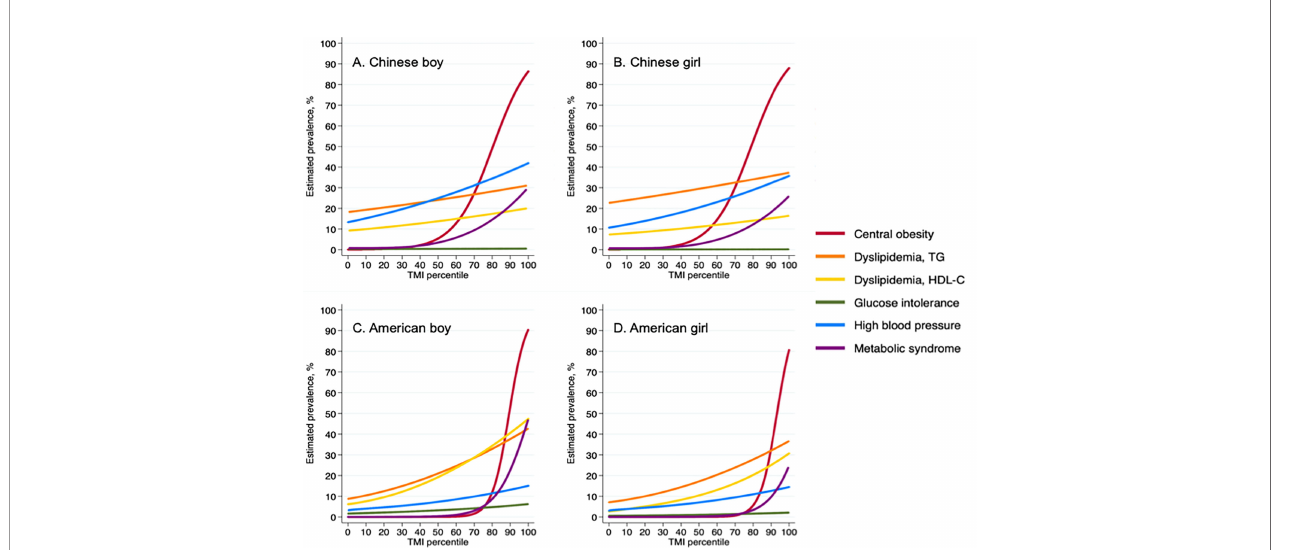
FIGURE 1 | Prevalence of cardiometabolic risk factors according to Tri-ponderal mass index percentiles among Chinese and American children. TMI, tri-ponderal mass index (kg/m 3 ); TG, triglyceride; HDL-C, high density lipoprotein cholesterol; FPG, fasting plasma glucose. (A) Chinese boy; (B) Chinese girl; (C) American boy; (D) American girl.